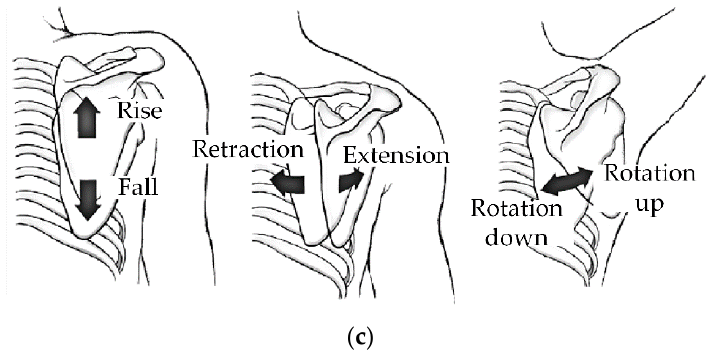
Figure 2. Motion form of the articulation in the scapular region. ( a ) Motion form of the acromioclavicular joint (AC); ( b ) Motion form of the sternoclavicular joint (SC); ( c ) Motion form of the scapulothoracic joint (ST).